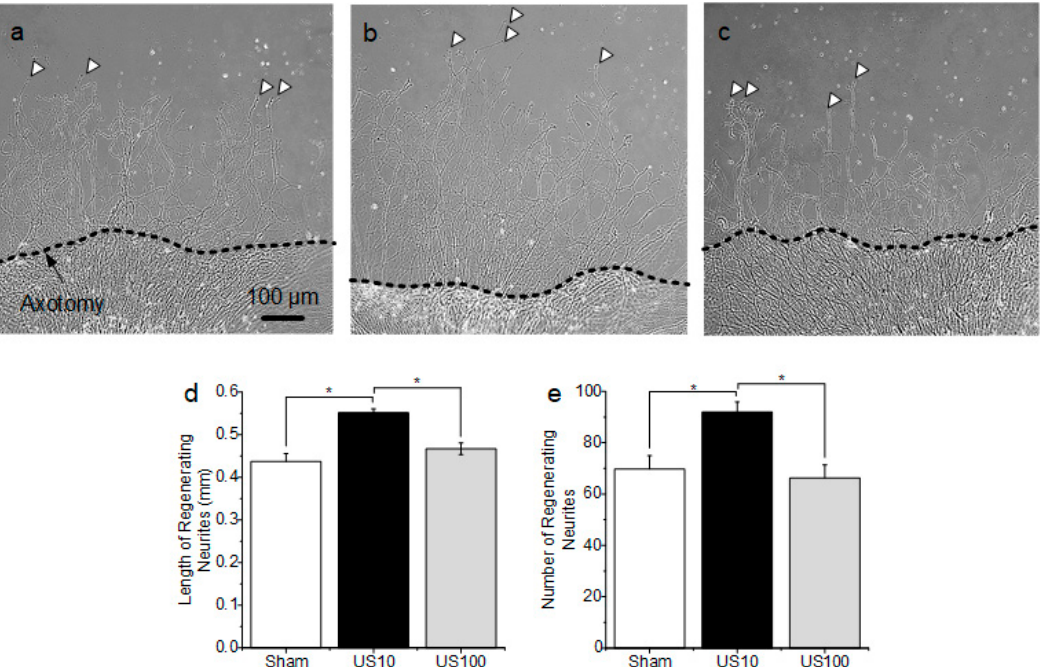
Figure 3. Evaluation of neurite regeneration of axotomized dorsal root ganglion (DRG) explants in response to ultrasound stimulation (US). ( a ) Representative images of regenerating neurites not treated with US (sham group). ( b ) Representative images of regenerating neurites treated with 10-Hz pulse-repetition frequency US (US10 group). ( c ) Representative images of regenerating neurites treated with 100-Hz pulse-repetition frequency US (US100 group). ( d ) Comparison of the lengths of regenerating neurites ( n = 4). ( e ) Comparison of the numbers of regenerating neurites ( n = 4). The data are expressed as the mean ± standard error of the mean (SEM); * p < 0.05.